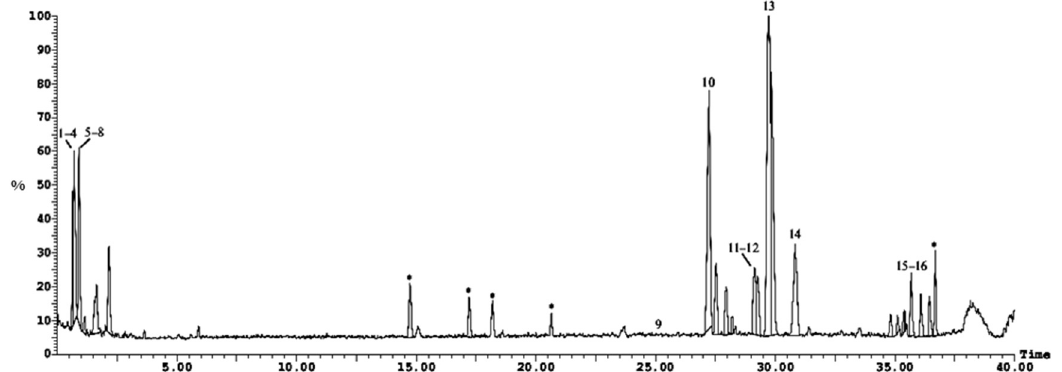
Figure 5. UPLS-ESI-MS chromatogram of dichloromethane fraction in positive (+) ionization mode. * Unidentified compounds, numbers 1–16 refer to the tentatively identified compounds in dichloromethane fraction.